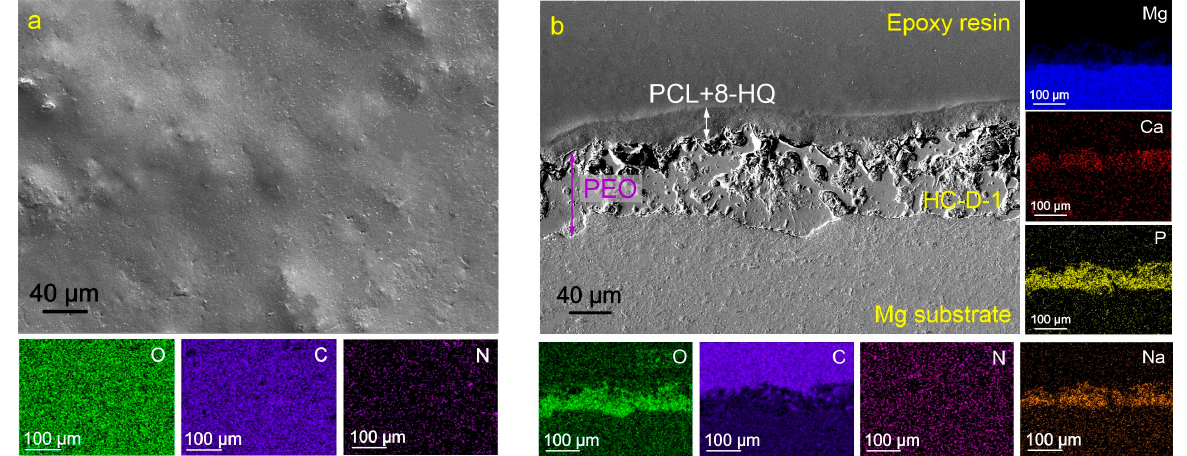
Figure 5. SEM images of the surface ( a ) and cross-section ( b ) of the HC-D-1-coated samples and maps of elements distribution over the sample’s surface ( a ) and thickness ( b ).